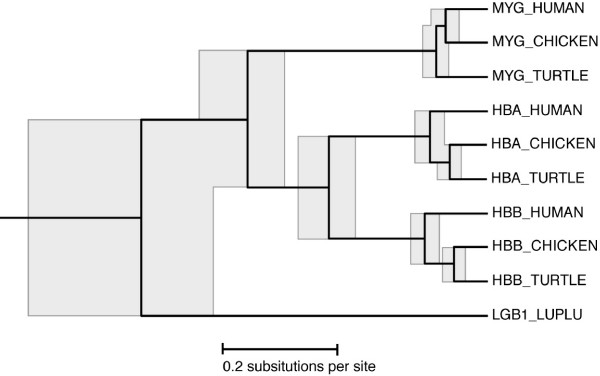
Maximum a-posteriori phylogeny. The maximum a posteriori tree (black) relating the ten globins of Fig. 5, and 95% confidence intervals of the node heights (grey boxes). Most of the tree's topology is well determined, with the exception of the myoglobin sub-tree. Alpha and beta chain sub-families both support the traditional ordering of birds, turtles and mammals, while the three myoglobin sequences support an unconventional phylogeny, as previously observed by Hedges and Poling [41]. However, the posterior probability for the topology of the myoglobin subtree is smaller than that for the remaining topology. The marginal posterior probability (estimated from the MCMC chain) for the monophyly of human and chicken myoglobin is 83.1%, followed by the conventional grouping of turtle and chicken at 11.9%. The third topologlcal arrangement of myoglobin occurred the remaining 5% of the time, suggesting significant homoplasy in this sub-family.